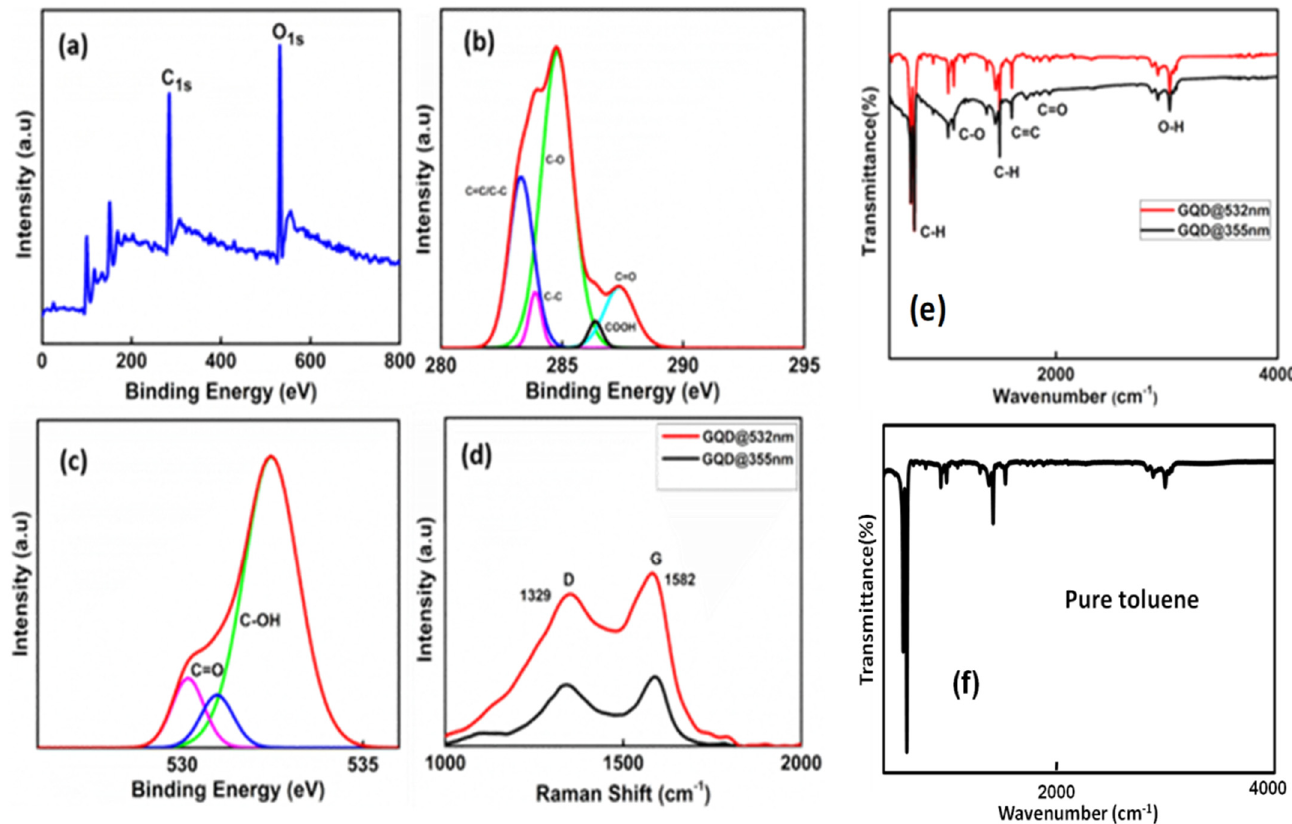
Figure 3. X-ray photoelectron spectroscopy (XPS) and Raman spectra of the laser synthesized GQDs. ( a ) Wide scan spectra. ( b ) C1s spectrum. ( c ) O1s spectrum. ( d ) Raman spectra. ( e , f ) FT-IR spectra.